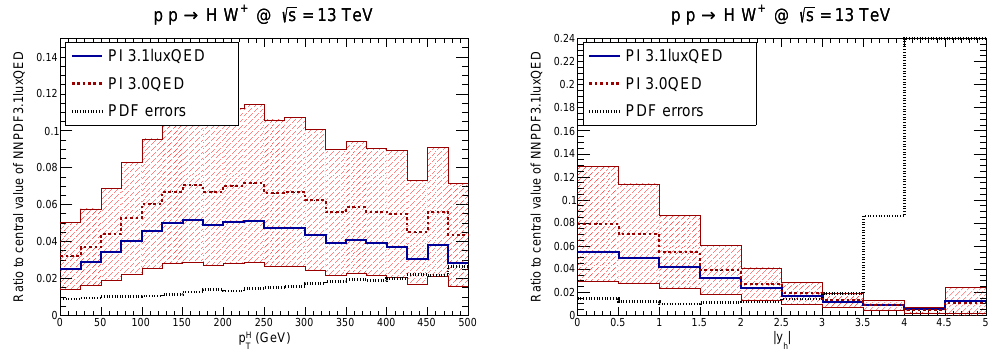
Figure 4.7: Same as Fig. 4.3 for Higgs production in association with a W boson, for the Higgs transverse momentum p h distribution (left), and its rapidity y T